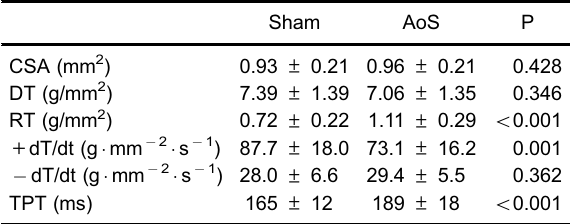
Table 3. Basal isometric contraction.